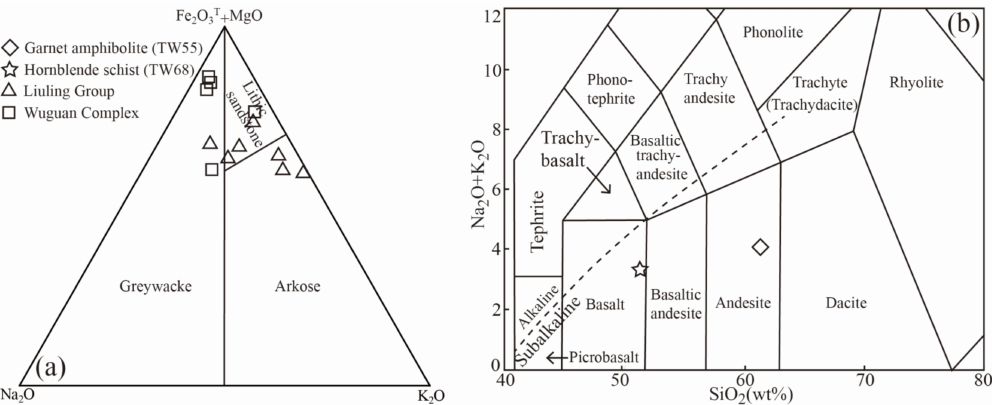
Figure 5. ( a ) Chemical classification diagram for discriminating siliciclastic sediments using (Fe 2 O 3T +MgO)-Na 2 O-K 2 O (after [59]). ( b ) Total alkali–SiO 2 (TAS) diagram for the classification of meta-igneous rocks from the Wuguan Complex (after [60]).